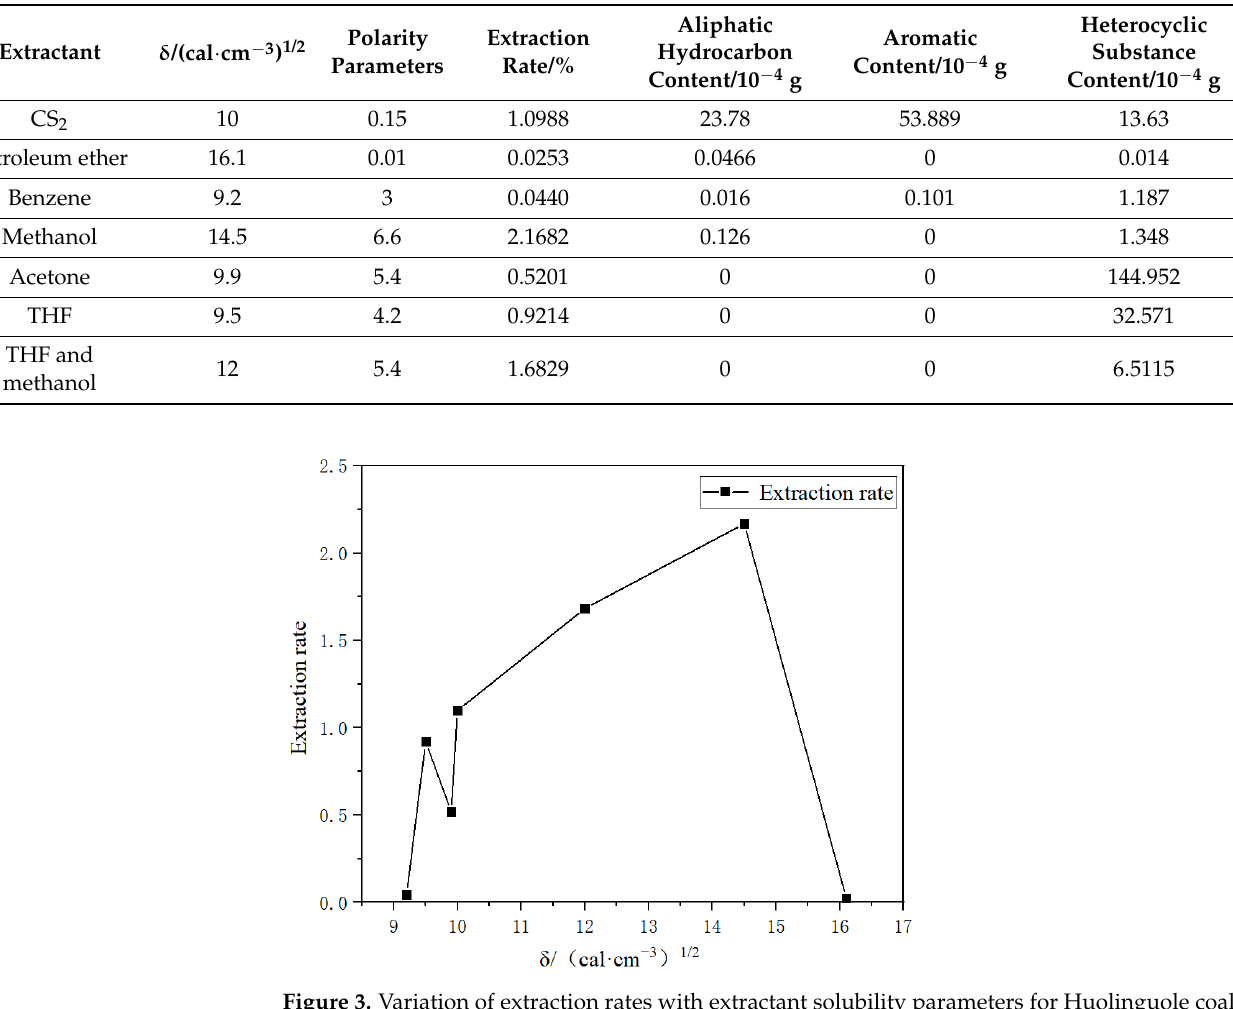
Figure 3. Variation of extraction rates with extractant solubility parameters for Huolinguole coal.